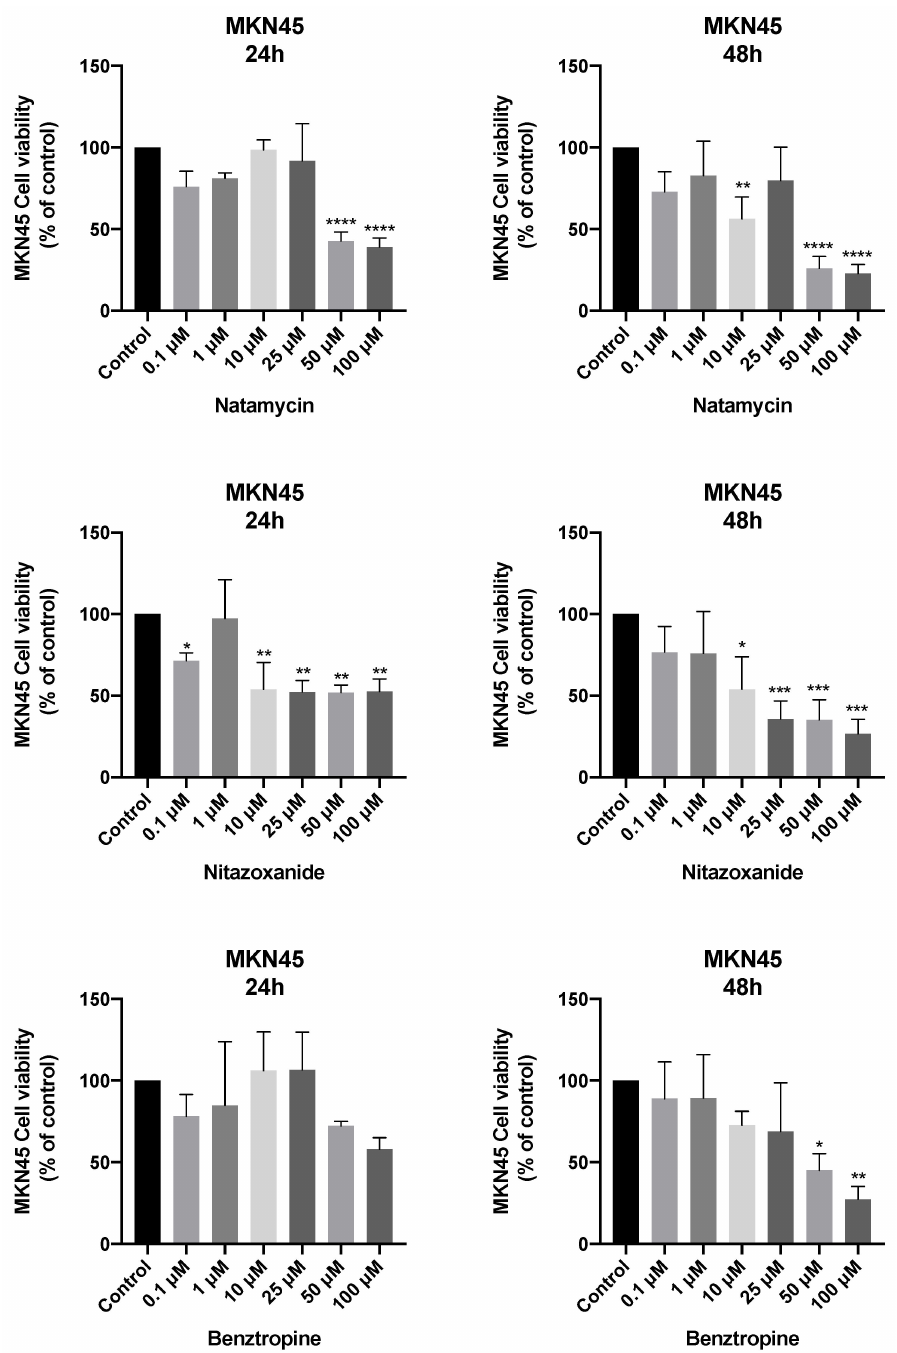
Figure 10. Viability of MKN45 GC cells incubated with different repurposed drugs alone. Cultured cells were seeded in 96-well plates and treated with each drug alone (0.1–100 µ M) for 24 and 48 h. Values are expressed as percentages of control and represent means ± SEM. Each experiment was conducted three times independently ( n = 3); * statistically significant vs. control at p < 0.05; ** statistically significant vs. control at p < 0.01; *** statistically significant vs. control at p < 0.001; **** statistically significant vs. control at p <